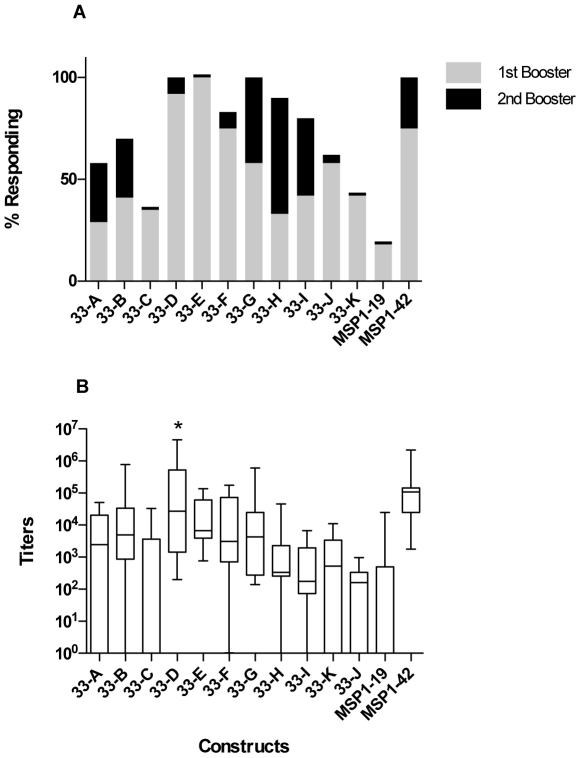
ELISA antibody responses against MSP1-19 in Swiss Webster mice immunized with recombinant truncated MSP1-42 proteins.Panel A, percent responsiveness of mice immunized with Constructs 33-A – 33-K after the first booster injection (grey) and after the second booster injection (black). Panel B, antibody titers of mice vaccinated with Constructs 33-A – 33-K. Results of tertiary bleeds are shown. Horizontal bars indicate mean antibody titers. ANOVA (p<0.05) indicated that the levels of antibody titers differed among groups. Asterisk indicates a significant difference (Turkey post-hoc test, p<0.05) between Construct 33-D and all other vaccination groups.